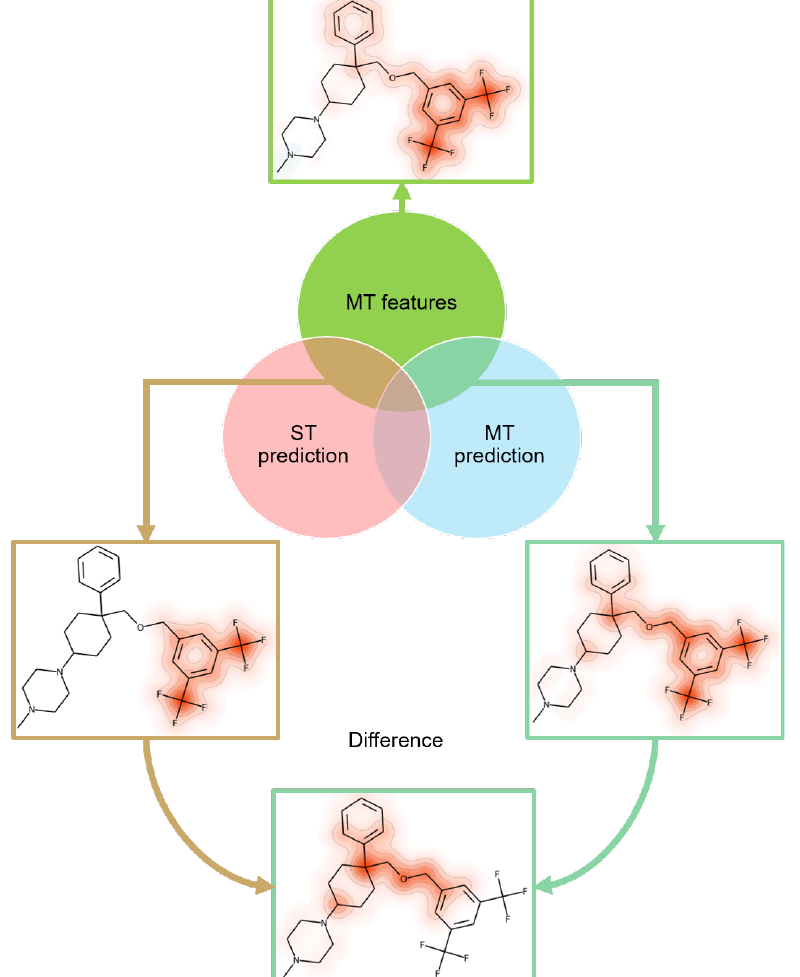
Figure 4. Feature mapping. For an exemplary MT-CPD that was correctly predicted using ST and MT models, different sets of features were mapped onto the structure. Green features at the top are from the MT models and the others represent overlapping features from the prediction of ST- and MT-CPDs using the ST model. Additional features from the MT-CPD prediction form the difference set at the